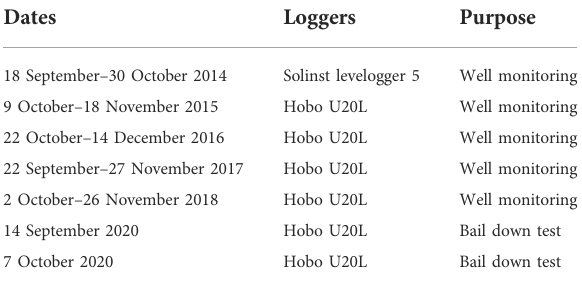
TABLE 2 Dates when wells were instrumented with water level loggers. Four wells and two channels were instrumented, and